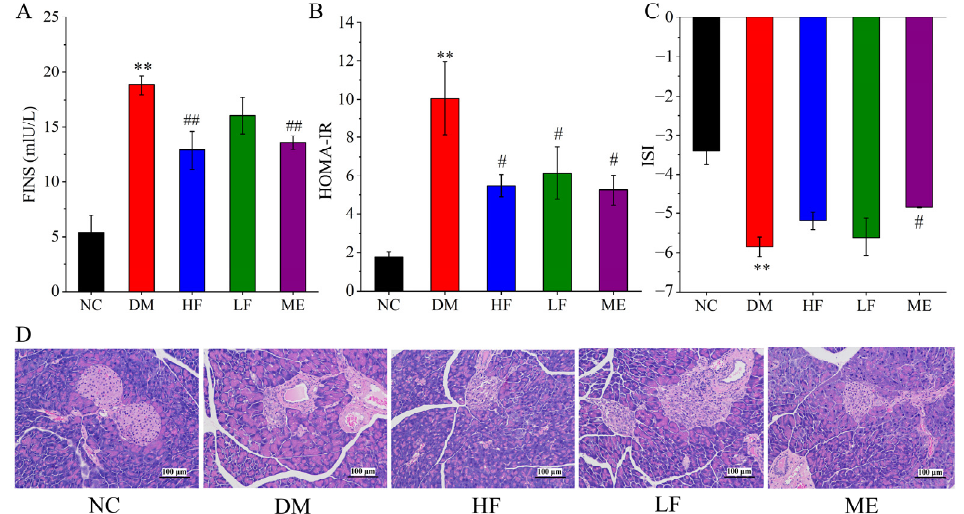
Figure 4. Effect of LJF on insulin activity: FINS ( A ), HOMA-IR ( B ), and ISI ( C ). Histology analysis of pancreas based on HE staining ( D ). ** p < 0.01 vs. NC group, and # p < 0.05 and ## p < 0.01 vs. DM group.